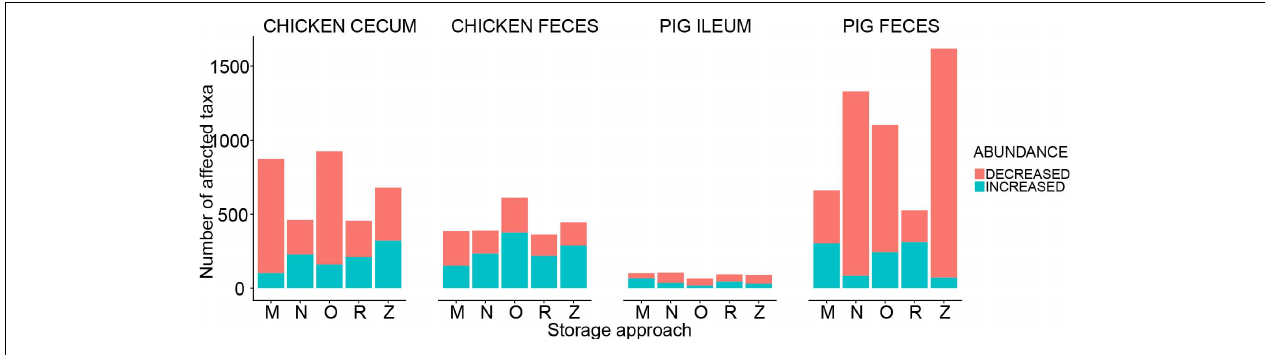
FIGURE 11 | Impact of storage approaches on differential abundances of microbiota. The bar plot shows the number of affected taxa (either increased or decreased) based on differential abundance analysis in chicken cecum, chicken feces, pig ileum, and pig feces samples. M: frozen at − 80 ◦ C, N: NAP buffer, O: OMNIgene-GUT buffer, R: RNALater, Z: ZYMO DNA/RNA